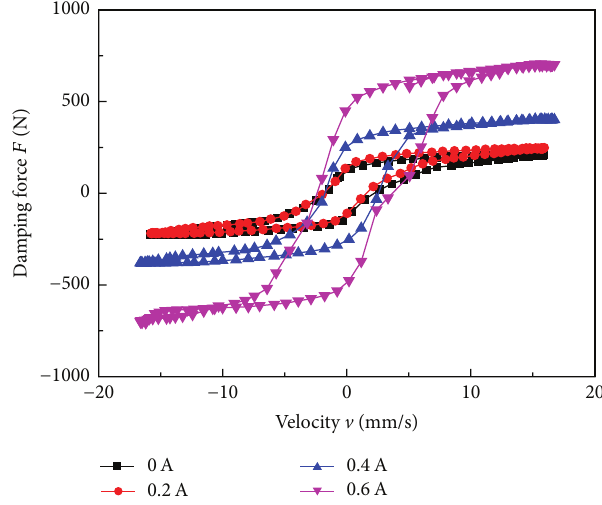
Figure 11: Damping force and displacement relation of the MR damper.